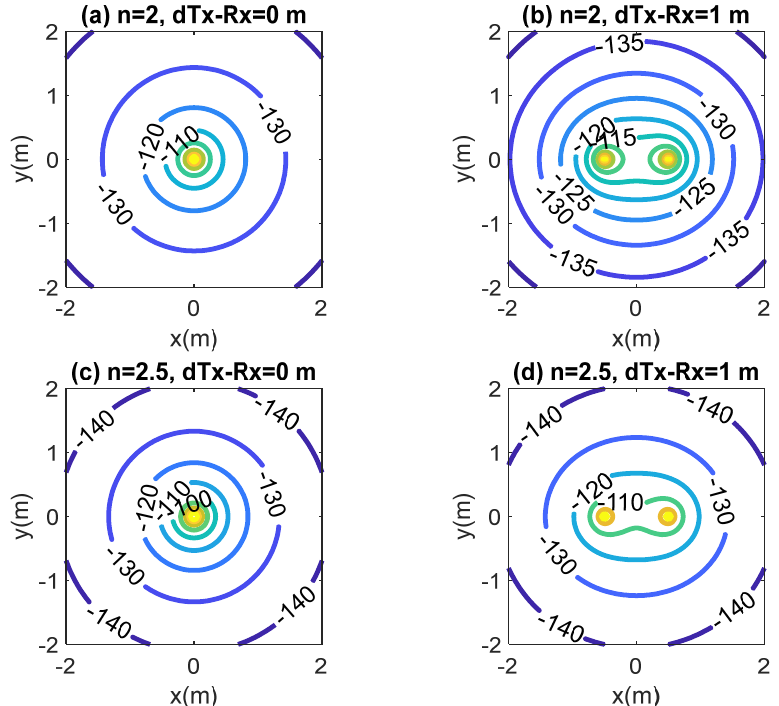
Figure 16. Simulated RSSI as a function of the location of the implanted backscatter assuming a depth of 10 cm inside the body for the monostatic case ( d Tx-Rx = 0 m) and bistatic case ( d Tx-Rx = 1 m). Path loss exponential factor n 1 = n 2 = 2 and n 1 = n 2 = 2.5.